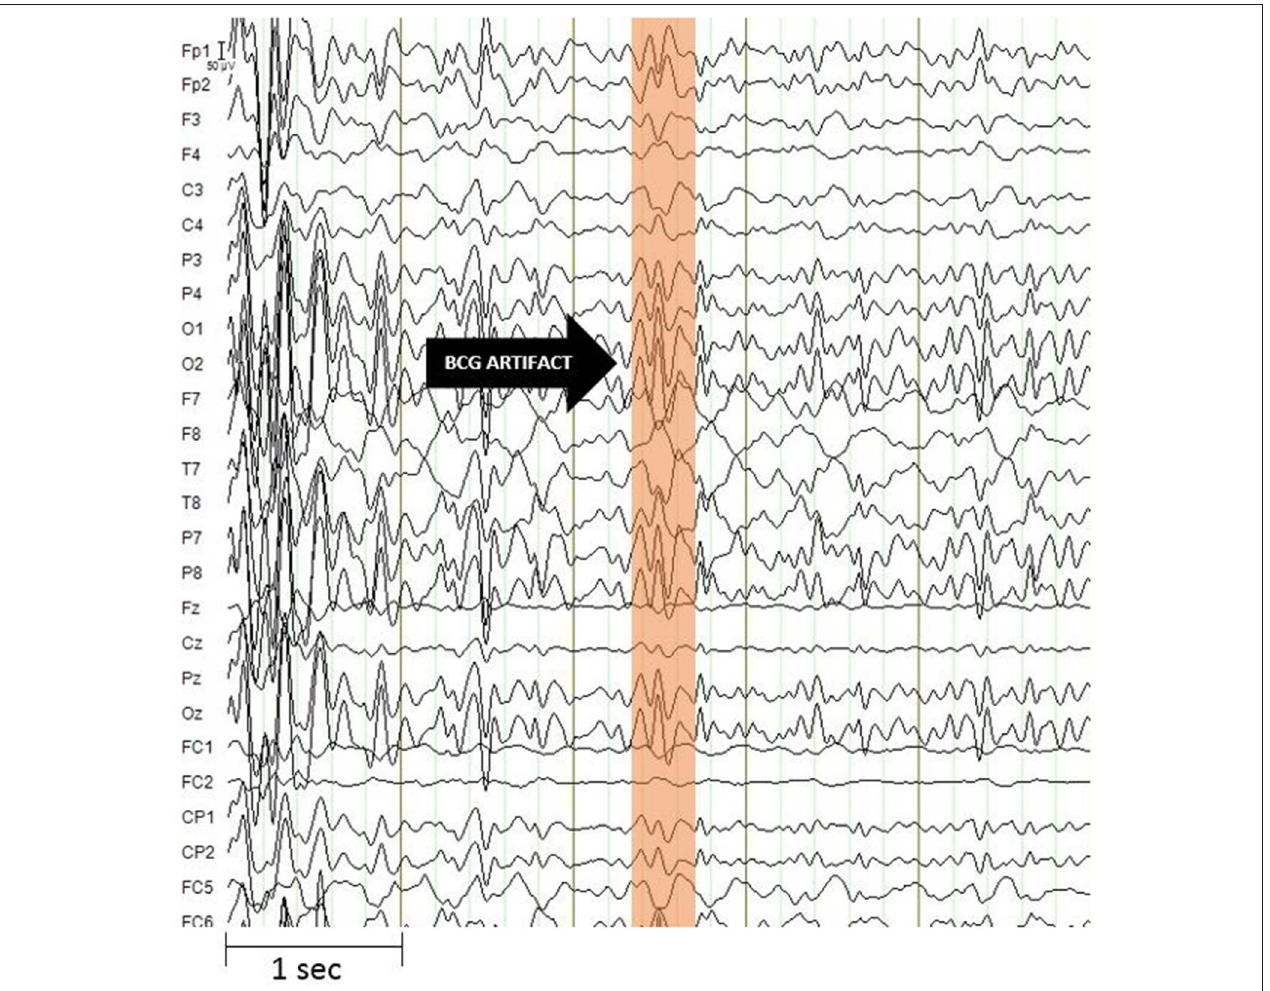
FIGURE 3 | Ballistocardiogram artifact. It has a maximum amplitude of about 100 microvolt and is most evident in the frequency range up to 30Hz. The artifact undergoes spatio-temporal variability linked to cardiac activity. Image obtained on a 40 years-old healthy volunteer with hybrid EEG-fMRI system and included for illustrative purpose